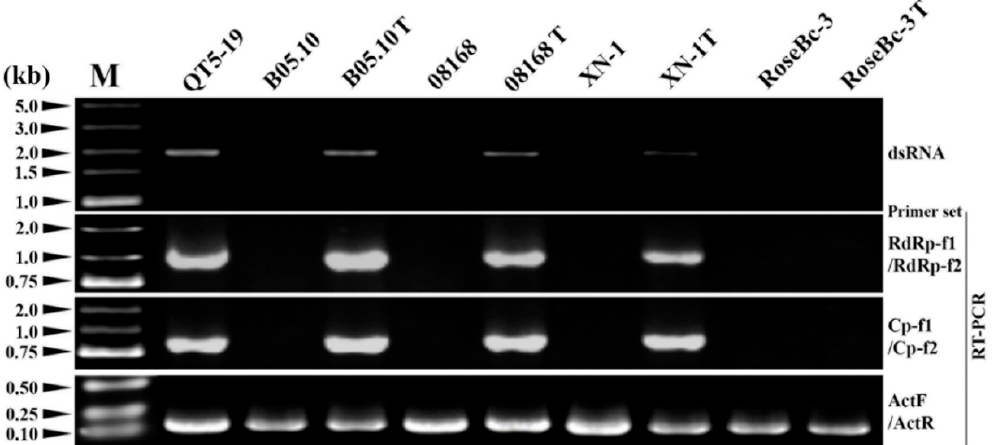
Figure 9. Detection of BcPV2 in different isolates of Botrytis cinerea by dsRNA profiling and RT-PCR with specific primers. M = DL5000 DNA marker (TaKaRa). Isolates B05.10T, 08168T, XN-1T, and RoseBc-3T were derived from B05.10, 08168, XN-1 and RoseBc-3 in the pairing cultures of QT5-19/B05.10, QT5-19/08168, QT5-19/XN-1 and QT5-19/RoseBc-3, respectively.